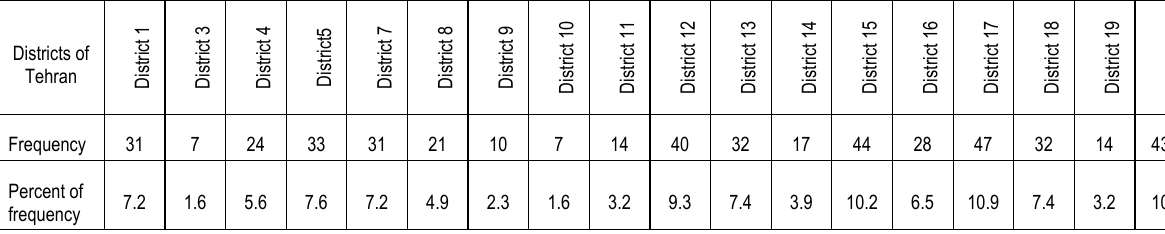
Table 3. Frequency of respondents to questionnaire of cooperation with separation of districts of Tehran Districts of Tehran